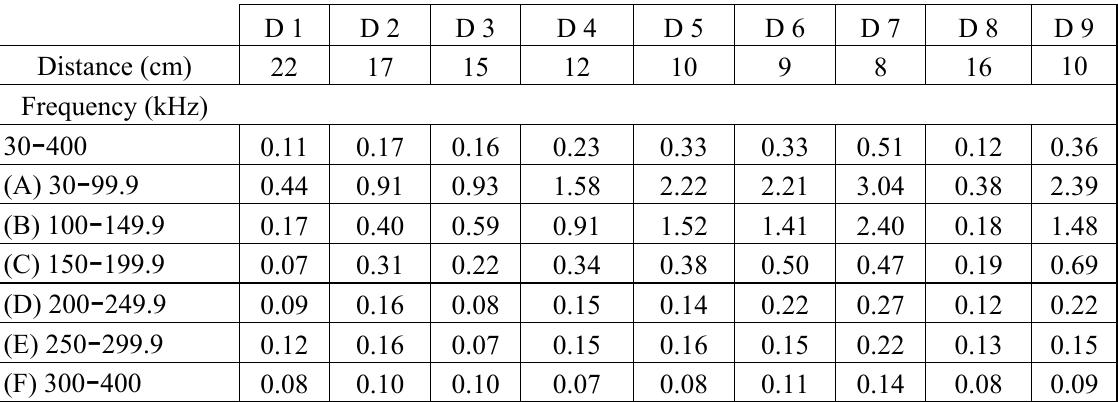
Table 2. RMSD-S for PZT